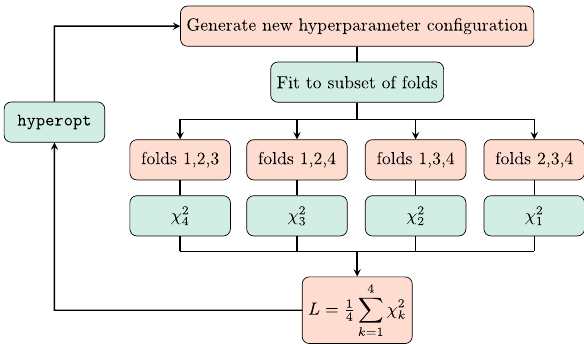
Fig. 7 Diagrammatic representation of the k -fold algorithm used for the hyperparameter optimization